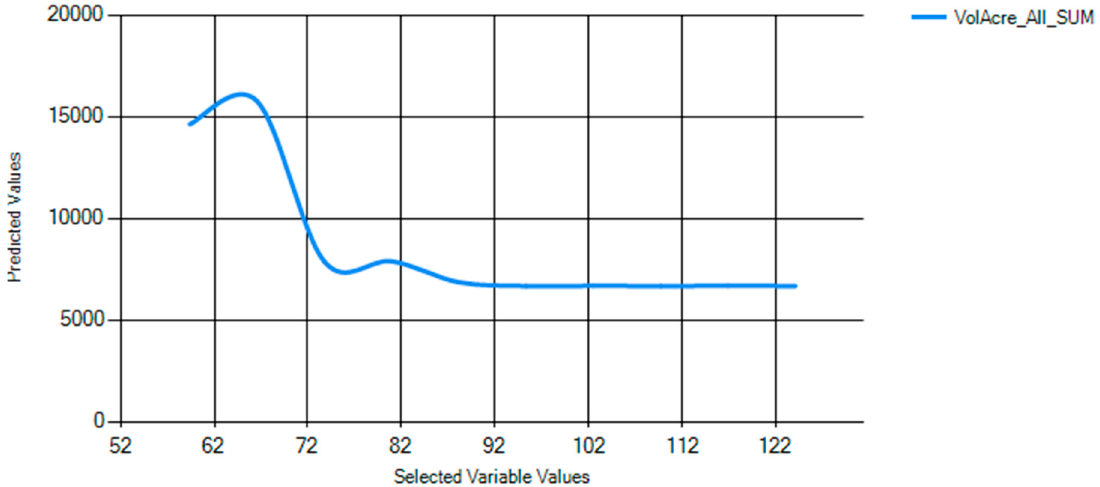
Figure 2. An example of the types of interactive graphics produced within the RMRS Raster Utility toolbar that visually describe the generalized association (predictive model) between board foot volume per acre of trees greater than 5 inches in diameter (the response variable) and twelve explanatory variables derived from remotely sensed imagery. The figure illustrates the functional relationship between volume and one explanatory variable called “mean-Band3”, while holding all other explanatory variables values at 30% of their sampled range.